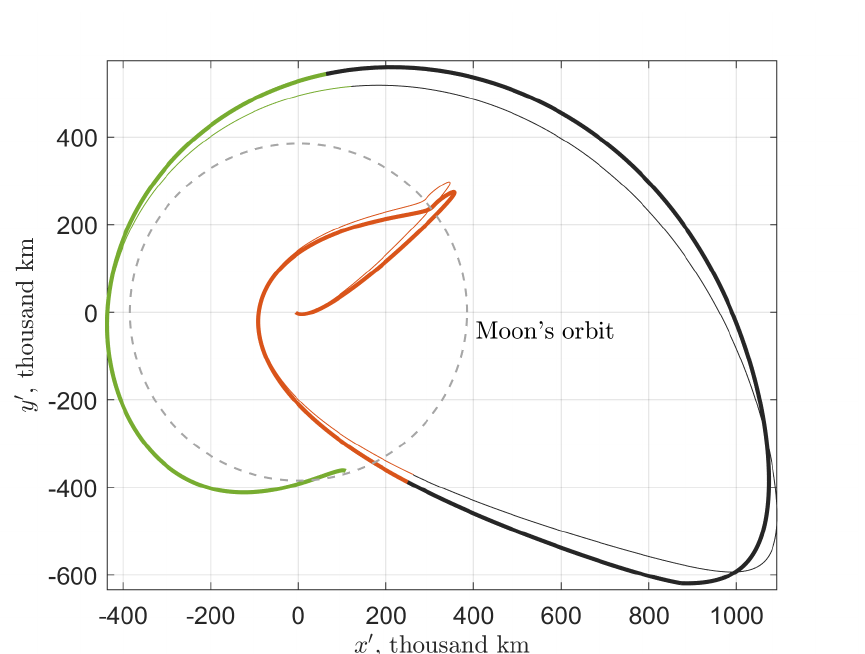
Figure 23. A sample SALT trajectory of the third type (with a retrograde lunar flyby): the patched three-body approximation (thin) and upon adaptation to the BR4BP (bold). As earlier, the adapted trajectory segments corresponding to the departing, arriving, and exterior legs, are colored the same (red, green, and black, respectively). Upon adaptation, the TLI burn has decreased from 3149 m/s to 3147 m/s. The burn phase has changed from 296.84 deg to 293.88 deg. The apogee TCM of 34.5 m/s has been